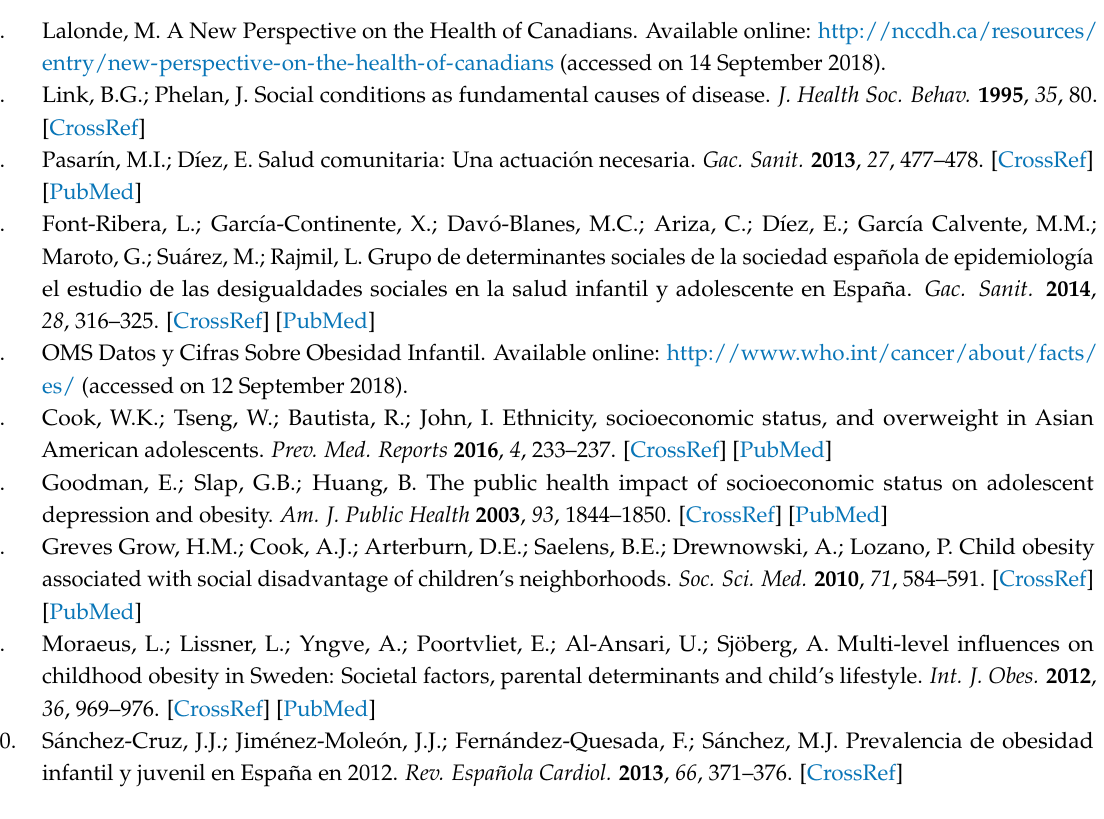
Table S1: Estimation of probability of the relationship between SES in the overall sample and network parameters, at the minimum contact intensity level. Table S2: Estimation of probability of the relationship between SES in the overall sample and network parameters, at the intermediate contact intensity level. Table S3: Estimation of probability of an analysis of the relationship between SES in the overall sample and network parameters, at the maximum contact intensity level. Table S4: Estimation of probability of an analysis of the relationship between SES in the female gender of the overall sample and network parameters, at the minimum contact intensity level. Table S5: Estimation of probability of an analysis of the relationship between SES in the female gender of the overall sample and network parameters, at the intermediate contact intensity level. Table S6: Estimation of probability of an analysis of the relationship between SES in the female gender of the overall sample and network parameters, at the maximum contact intensity level. Table S7: Estimation of probability of an analysis of the relationship between SES in the male gender of the overall sample and network parameters, at the minimum contact intensity level. Table S8: Estimation of probability of an analysis of the relationship between SES in the male gender of the overall sample and network parameters, at the intermediate contact intensity level. Table S9: Estimation of probability of an analysis of the relationship between SES in the male gender of the overall sample and network parameters, at the maximum contact intensity